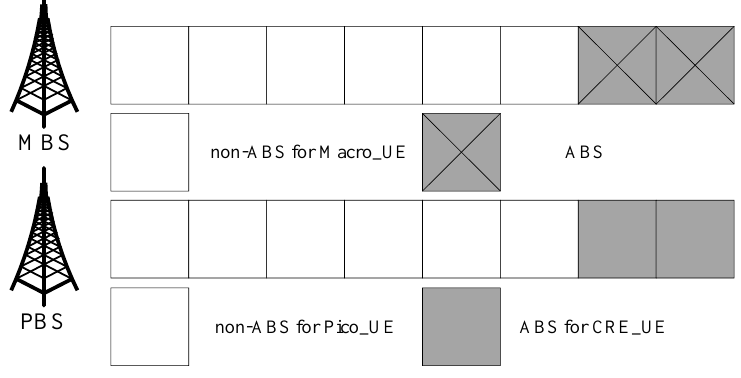
Figure 2. Basic principle of ABS.